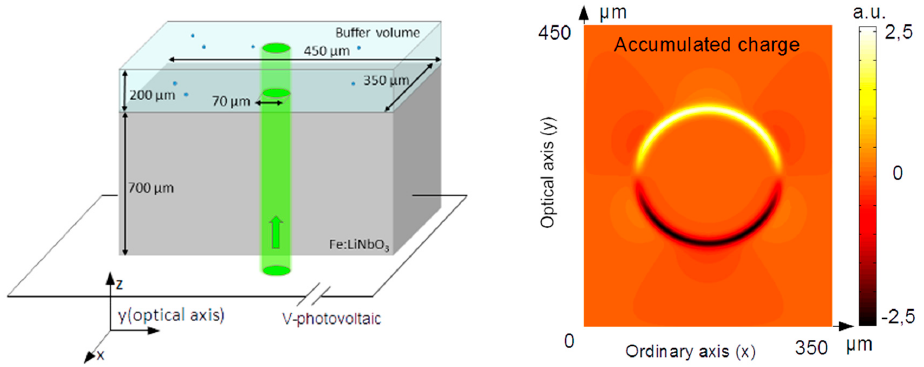
Figure 2. Scheme of the ideal system, including a photovoltaic potential generator, considered to evaluate Q ( x , y ) ( on the left ) and space charge distributions obtained considering the above reported data ( on the right ).